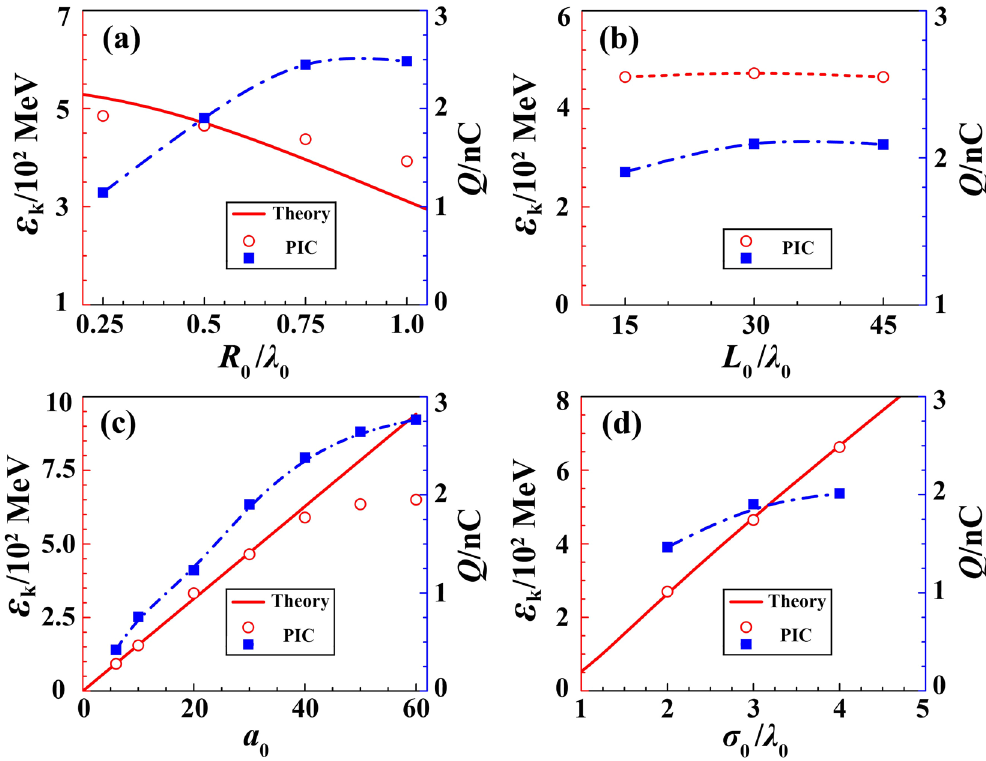
Figure 6. Parametric influence of the fiber radius R 0 ( a ) and length L 0 ( b ), the laser dimensionless parameter a 0 ( c ) and focal size σ 0 ( d ) on the achieved bunch energy and charge. The blue square denotes the electron charge, while the red circle shows the electron